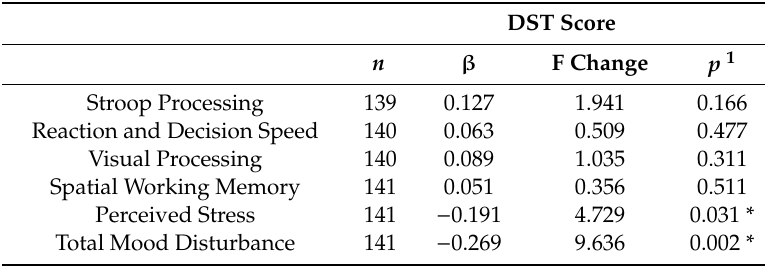
Table 5. Standardized weights of the relationship between diet quality (DST) and cognitive and mood outcomes after adjusting for covariates.